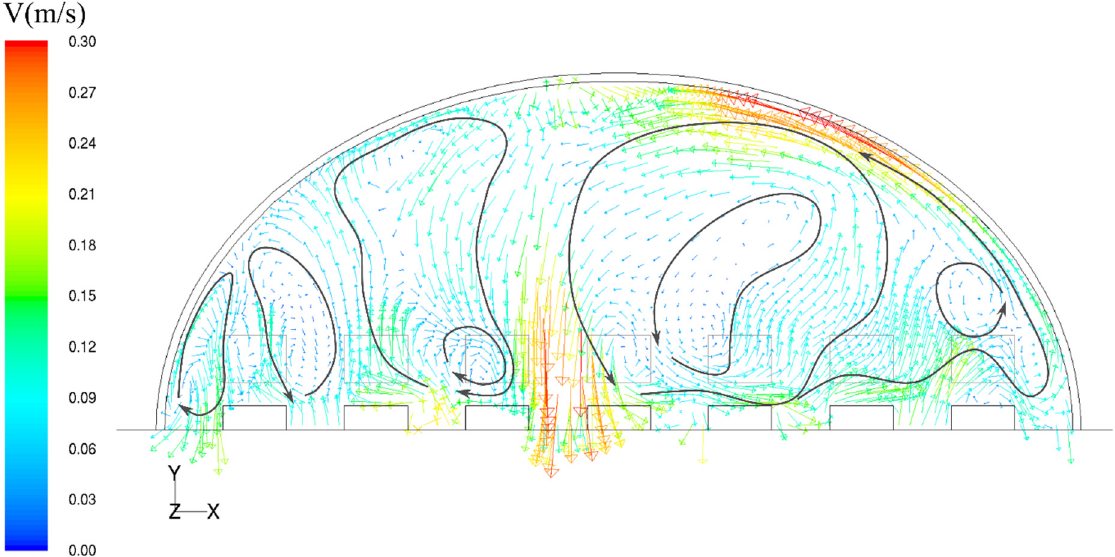
Figure 9. Velocity field inside the greenhouse at a distance z = 19 m from the door, with reconstitution of air circulation within the greenhouse.